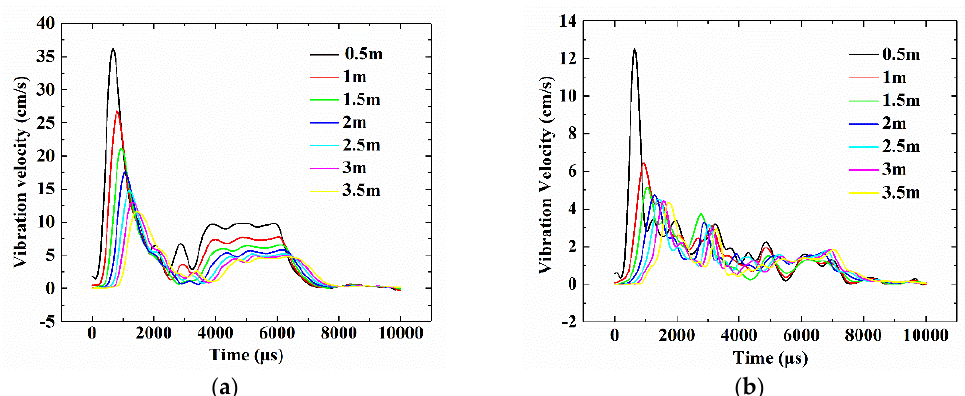
Figure 16. Particle velocity curves of monitoring points at different directions:( a ) particle velocity-time curves in the primary impact direction; ( b ) particle velocity-time curves in the secondary impact direction.